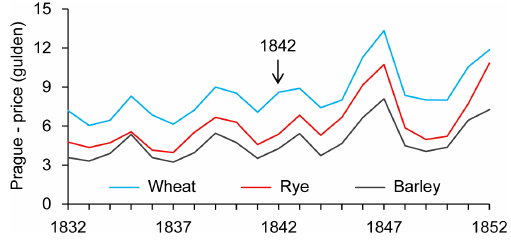
Figure 11. Fluctuations in grain prices (wheat, rye, barley) in Prague during the 1832–1852 period (data from Schebek,